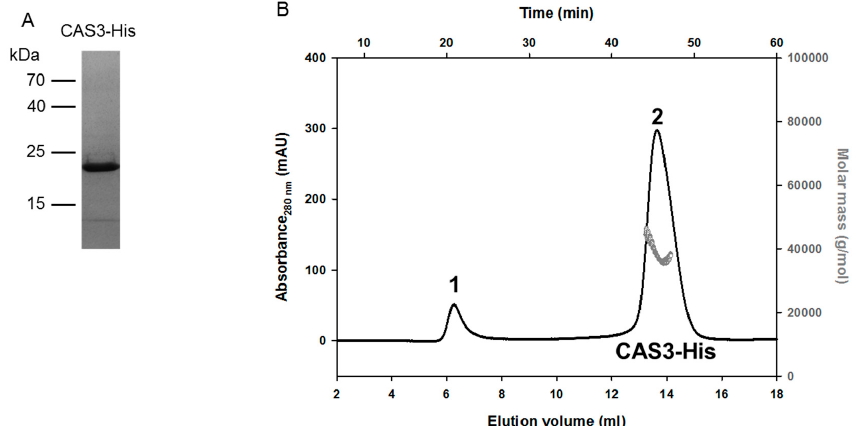
Figure 1. Purification and size-exclusion chromatography (SEC) of carbonic anhydrase 3 (CAS3)-His on a Superdex 200 10/300 column coupled with multi-angle laser light scattering. ( A ) Coomassie-stained, 15% SDS gel of purified CAS3-His. After washing of unbound proteins, the His-tagged enzymes were eluted by addition of 500 µL of elution buffer. Then, 10 µL of the protein solution was separated by SDS-PAGE. The expected protein size is 20.36 kDa. ( B ) Size-exclusion chromatography CAS3-His (black line) on a Superdex 200 10/300 column coupled with multi-angle laser light scattering (gray line). The reference proteins for SEC had the following elution profile: 670 kDa = 8.16 mL (thyroglobulin), 158 kDa = 12.54 mL ( γ -globulin), 44 kDa = 15.08 mL (ovalbumin), 17 kDa = 17.21 mL (myoglobin), 1.35 kDa = 20.46 mL (vitamin B12). The calculated molar mass of CAS3 amounts to 38,650 g ∙ mol − 1 (±0.1%), which corresponds to 1.9 times of the CAS3 monomer (20.36 kDa) (C). Peak 1 in the CAS3 elution profile is very likely due to protein aggregates that eluted close to the void volume of the column. Peak 2 represents the CAS3-His protein. Table 1. Kinetic parameters for the CO 2 hydration reaction [24] catalyzed by the human cytosolic enzymes hCA I and II ( α -class CAs) at 20 °C and pH 7.5, and the β -CAs Can2, CalCA (from Cryptococcus neoformans and Candida albicans , respectively), SceCA (from Saccharomyces cerevisiae ), as well as the enzymes from Sordaria macrospora , CAS1–CAS3, measured at 20 °C, pH 8.3. Inhibition data with the clinically used sulfonamide acetazolamide (5-acetamido-1,3,4-thiadiazole-2-sulfonamide) are also provided.